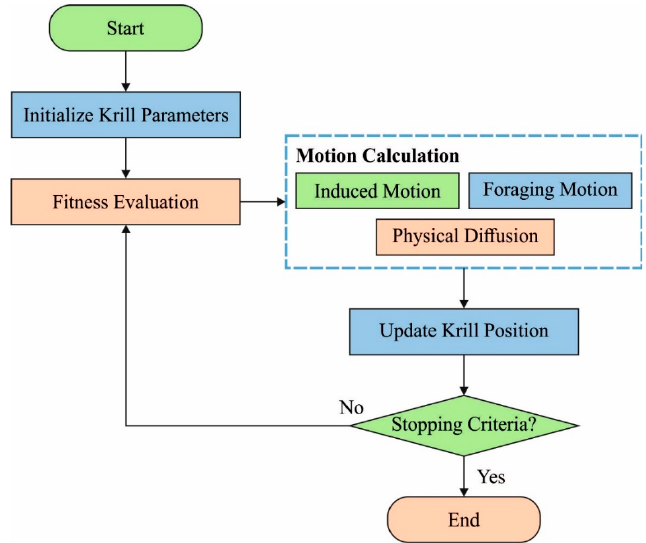
Figure 2. Flowchart of KH.